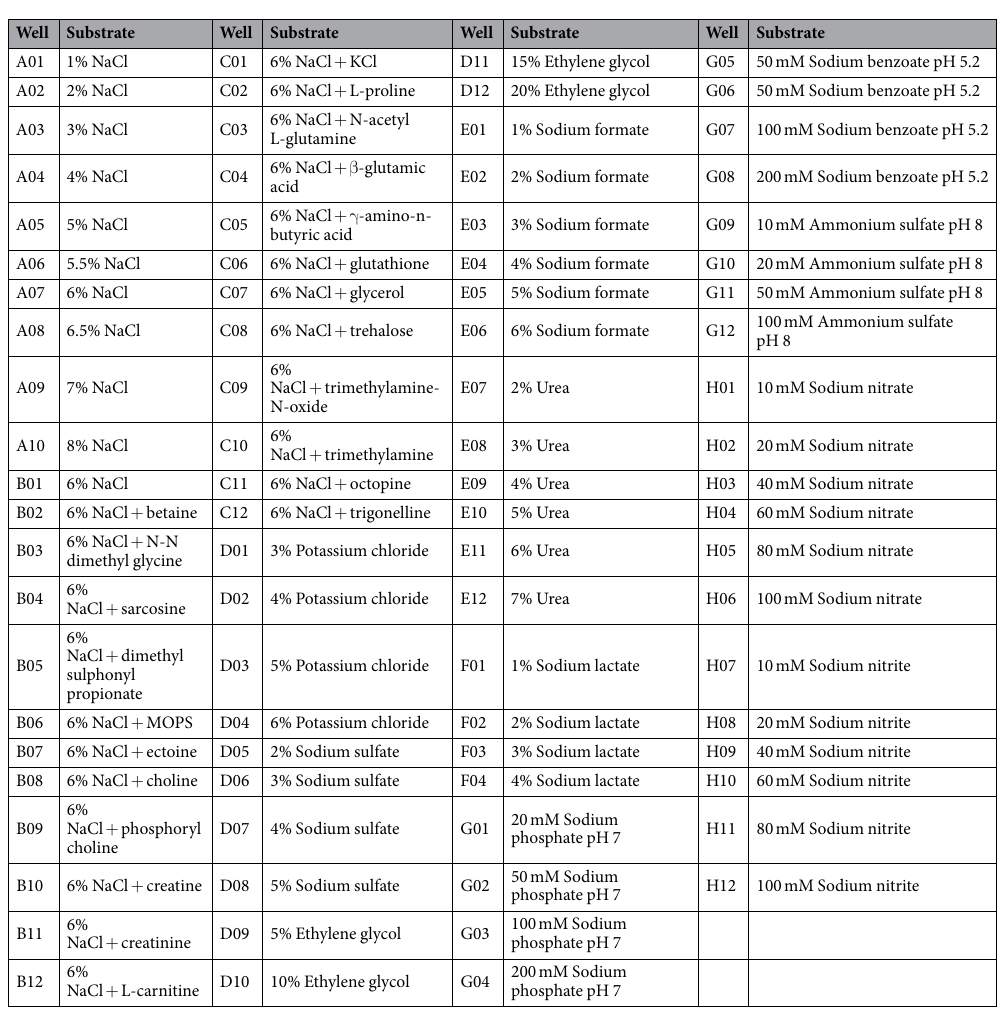
Table 5. Substrates in the PM 9 Biolog MicroPlate metabolized by the larval gut bacterium Enterococcus mundtii from the diamondback moth a . a Content listed in the columns “Well” and “Substrate” refer to the layout of the Biolog PM Microplate; the numbers in the Well column indicate the substrates tested in the Biolog PM